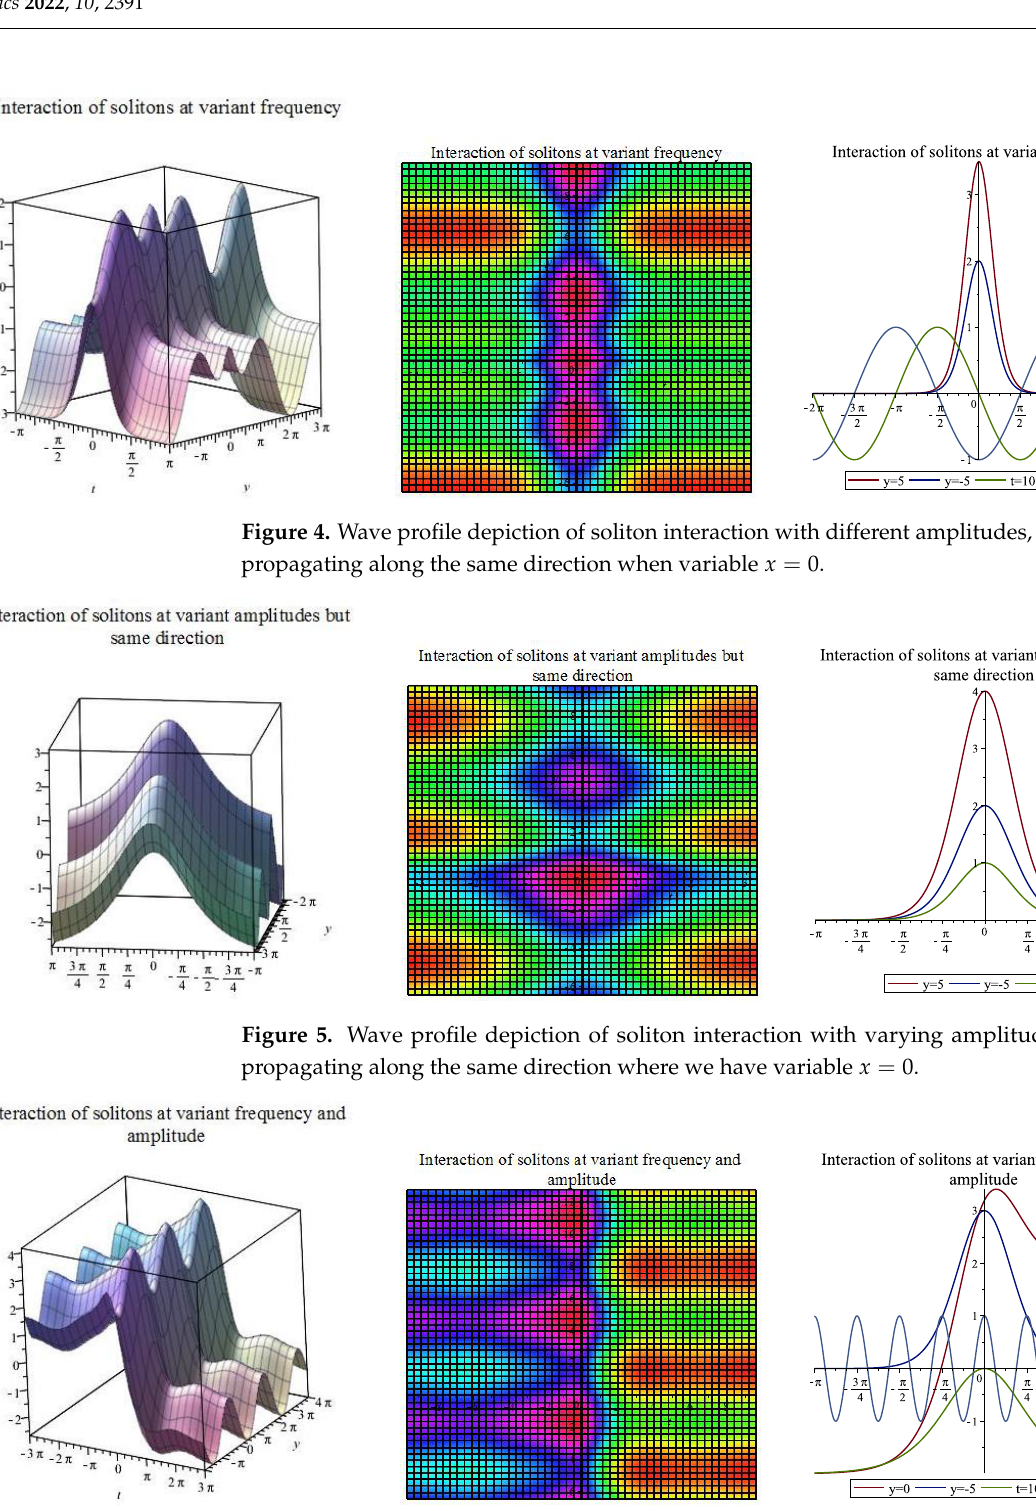
Figure 6. Wave profile depiction of soliton interaction with variant amplitudes and frequency with the wave propagation taking place at different level when x =